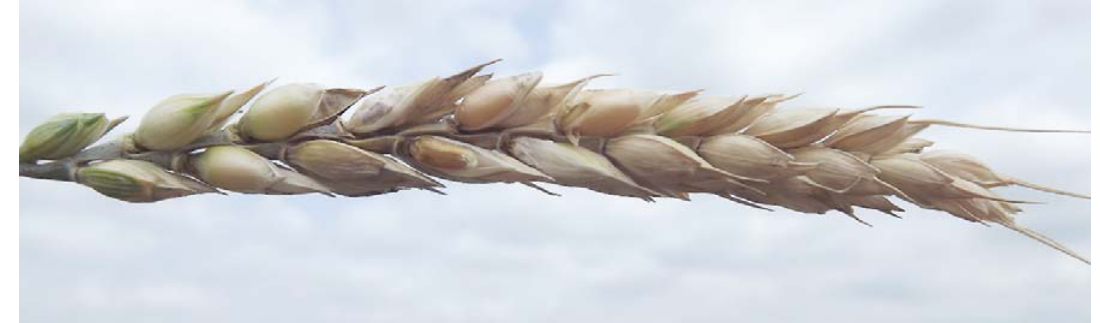
Figure 15. A medium resistant genotype with one spikelet infected, and above the infection site, normal size grains sit in the spikelet without shriveling (except the spikelet above the infected one) and only the light brown discoloration shows the accelerated ripening process. From this head, we will have a yield close to the full healthy heads.